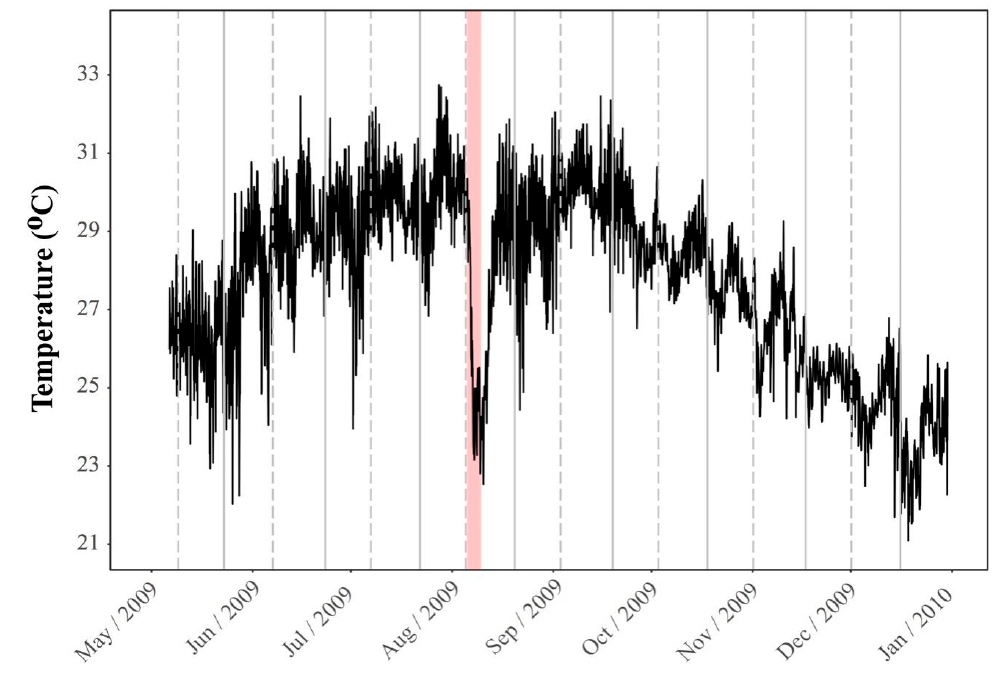
Figure 6. The in situ hourly average seawater temperatures at 2 m depth in Outlet (OL) from 6 June 2009 to 31 December 2009. The vertical dotted and solid lines indicate full moon and new moon, respectively. The pink area indicates the period, from 5th August. 20:30 to 10th August 5:30 2009, the sea warning for typhoon Morakot, the deadliest one in the history of Taiwan, was issued by the Central Weather Bureau.